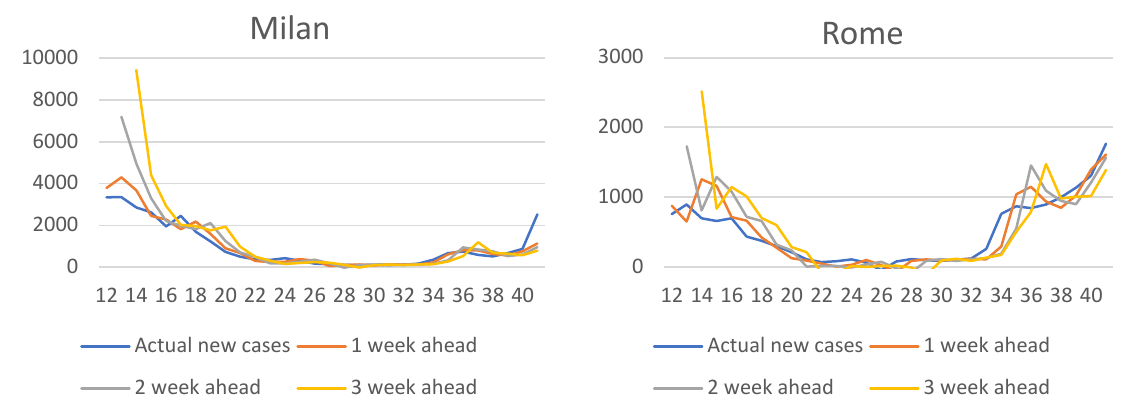
Figure 12. 1, 2 and 3 steps ahead forecasts compared with actual cases for Milan and Rome provinces.